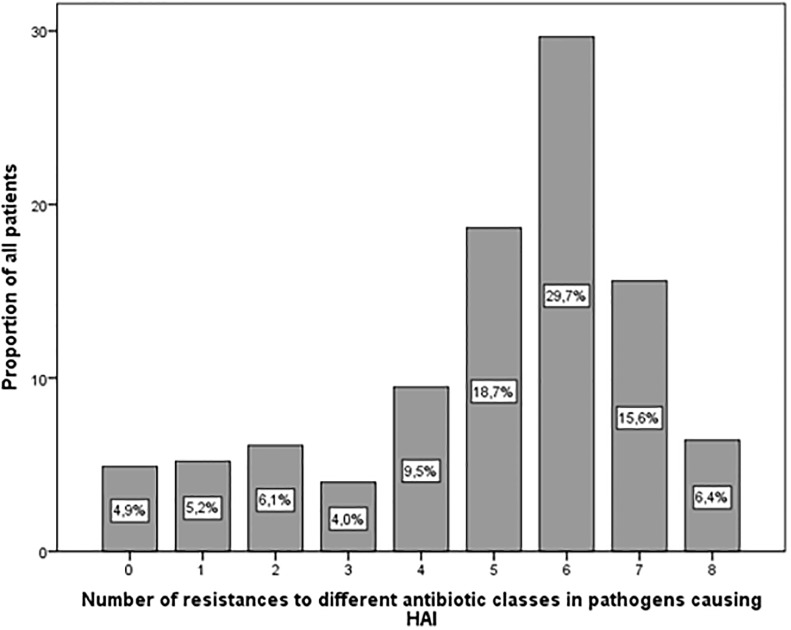
Multiple antibiotic resistance (MAR).Proportion of patients with hospital-acquired infections caused by gram-negative bacteria (GNB) with antibiotic resistance (ABR) to between 0 and 8 antibiotic classes. These classes included antipseudomonal cephalosporins, penicillins, carbapenems, fluoroquinolones, aminoglycosides, monobactams, polymyxins, folate pathway inhibitors.